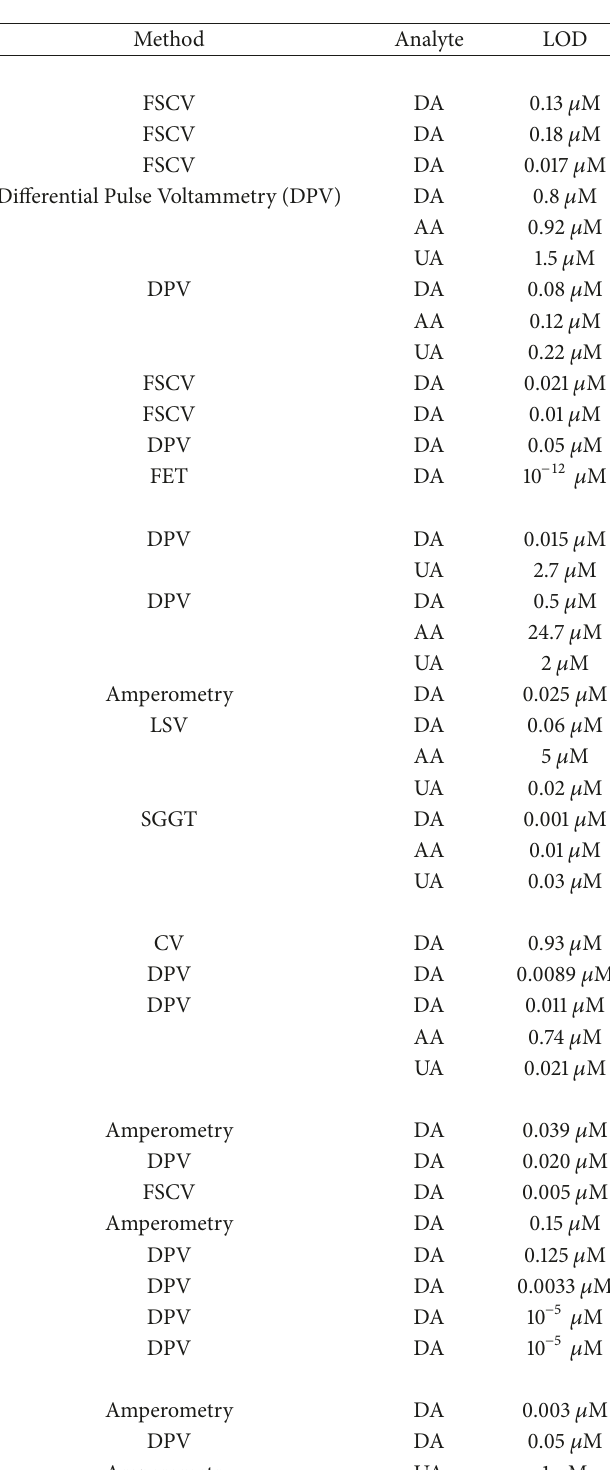
Table 1: Carbon nanomaterial-based electrochemical sensors for detection of dopamine, ascorbic acid, and uric acid. The table is reproduced with permission from